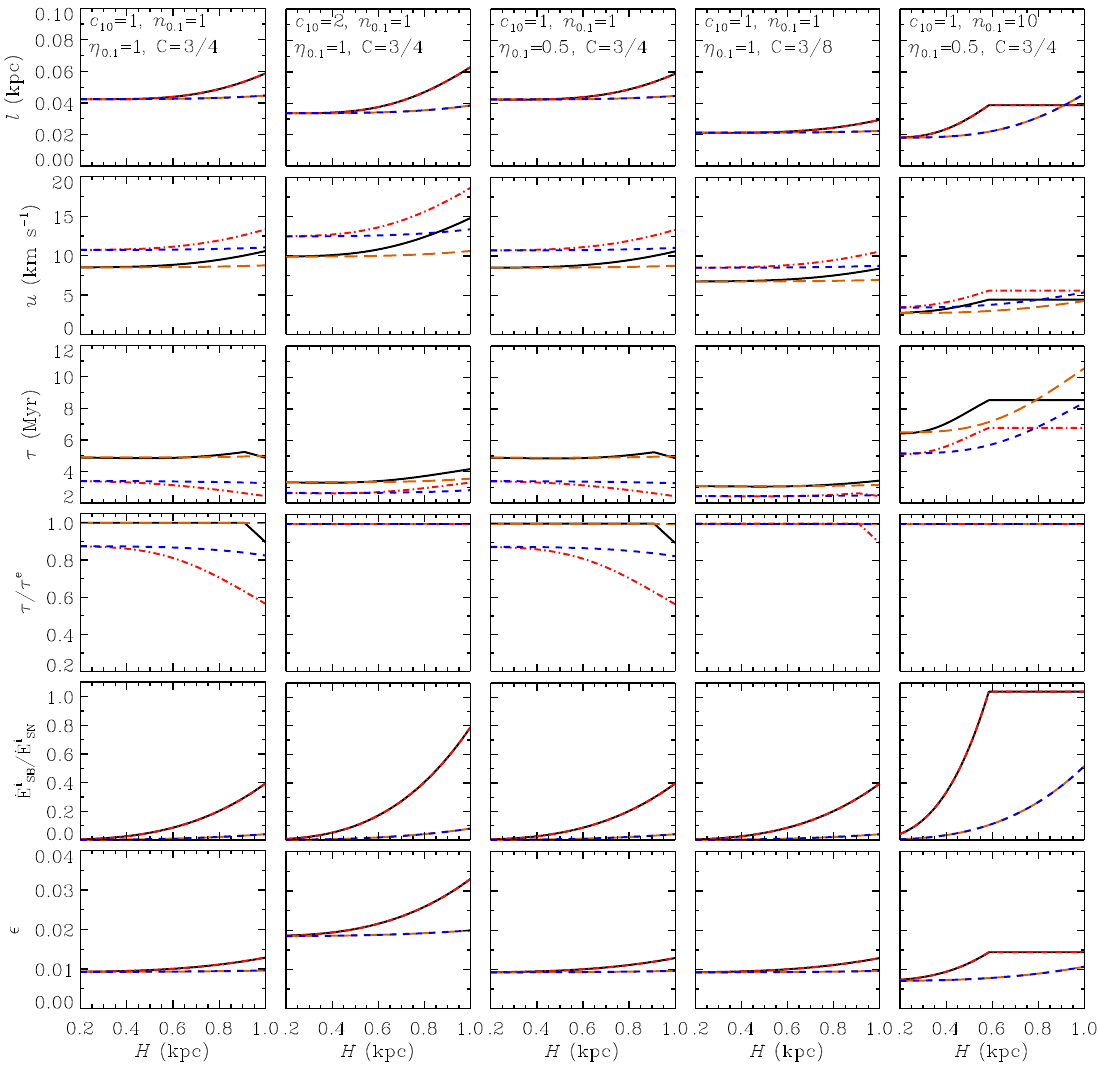
Figure 5. Similar to Figure 3 but for the case ξ =